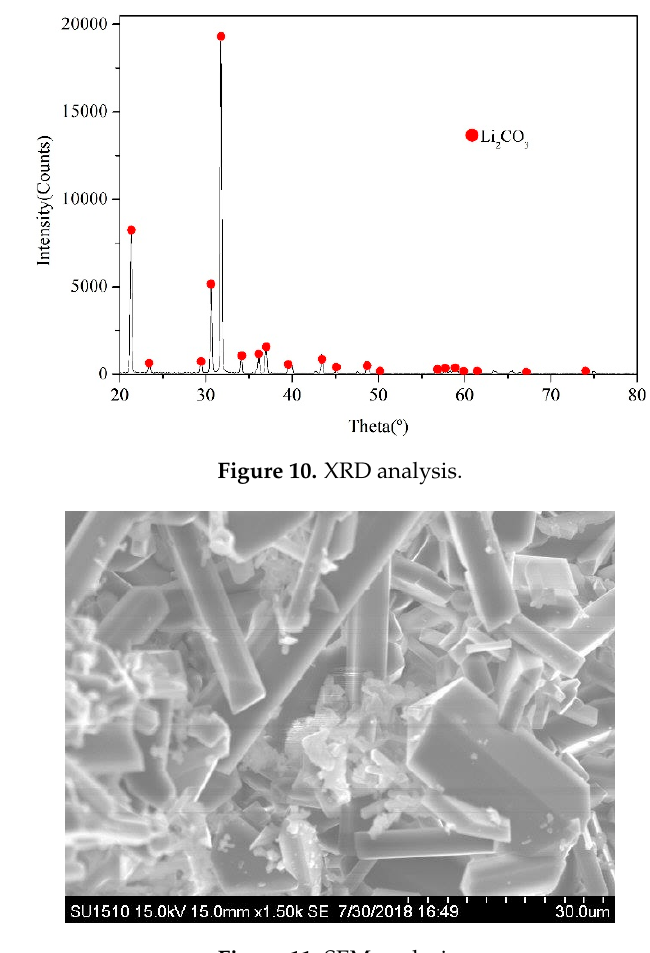
Figure 11. SEM analysis. Figure 11. SEM